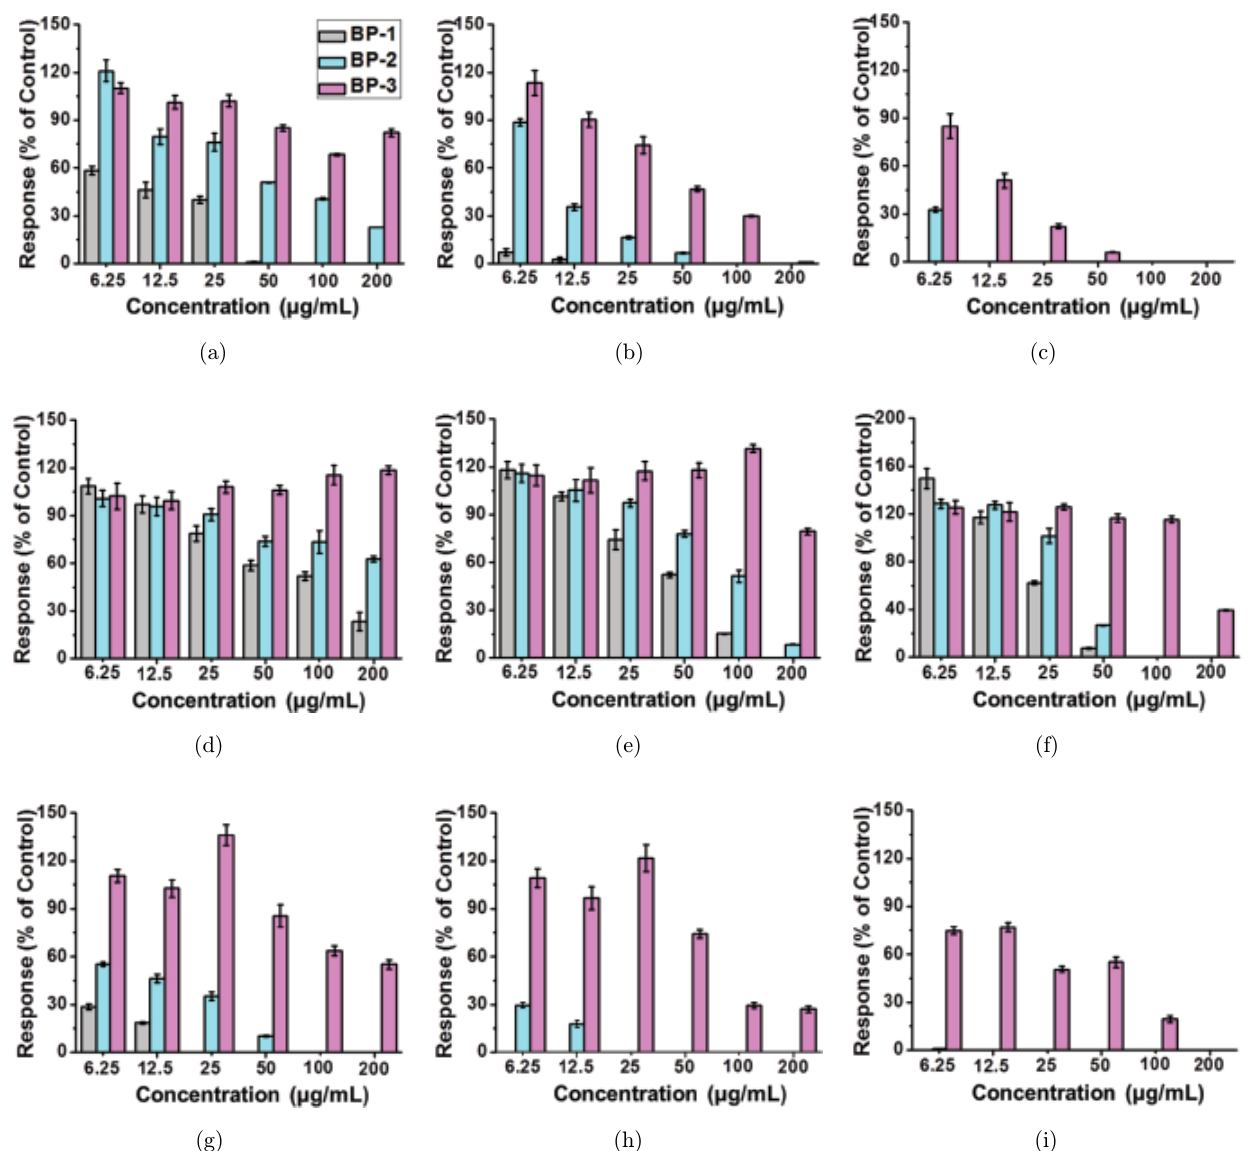
Fig. 1. The dependence of cell viability on size, concentration of BP, exposure time and cell lines. Cell lines: NIH 3T3 (a – c), HCoEpiC (d – f) and 293T cells (g – i). Exposure time: 12 h (a, d, g), 24 h (b, e, h) and 48 h (c, f, i).